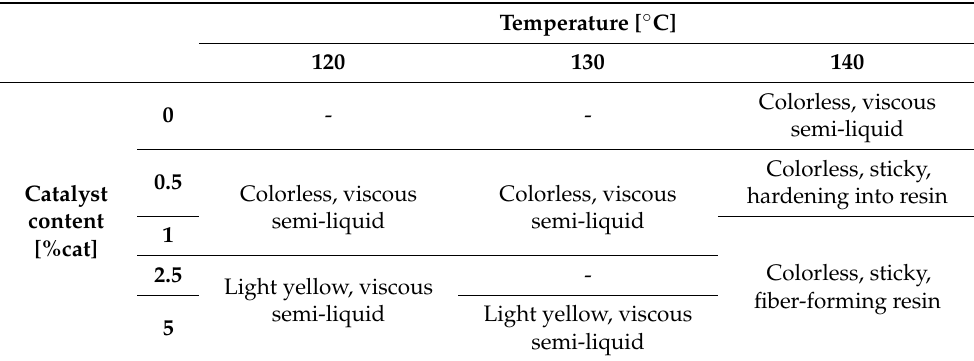
Table 1. The performance features of the reaction products at room temperature.